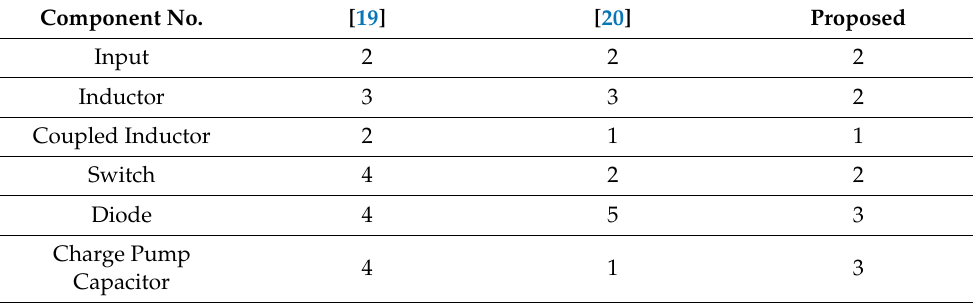
Table 6. Comparison between the existing [19,20] and the proposed circuits. Component No.